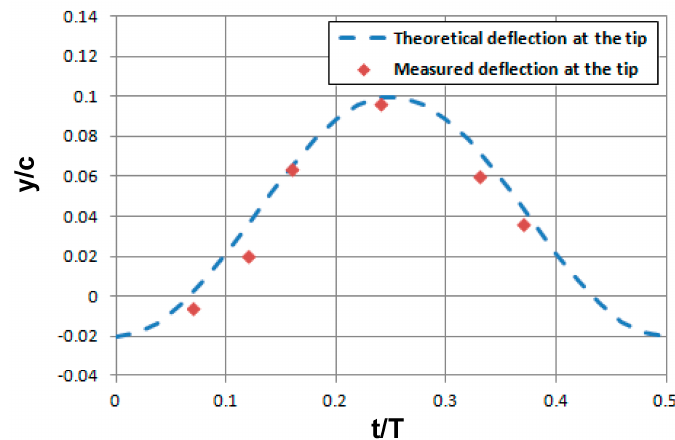
Figure 19. Non-dimensional vertical deflection at the wing tip along the flap movement vs. non-dimensional time (T is the period of flapping), at Re = 30,000 and AOA = 12°. The dots represent the quarter chord of each measurement.